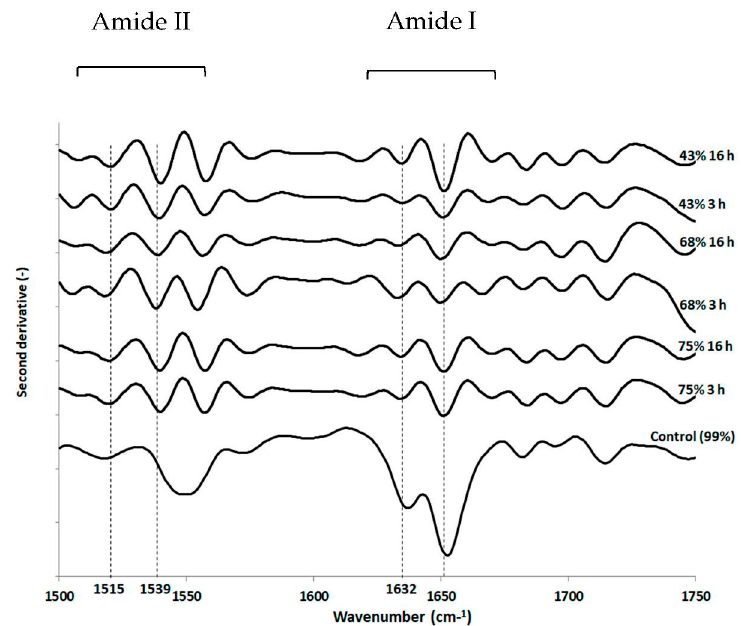
Figure 5. FTIR transmission spectroscopic analysis of L. monocytogenes EGDe components after de- hydration. Cells were dehydrated at 25 °C and 75%, 68% or 43% RH for 3 h or 16 h and then instan- taneously rehydrated in PBS. Untreated cells (control) were maintained at 99% RH. FTIR spectro- scopic analysis was performed on the second derivative spectra, as explained in the Materials and Methods section. Randomly selected second derivative spectra ranging from 1500 cm − 1 –1750 cm − 1 in the Amide I and Amide II regions are